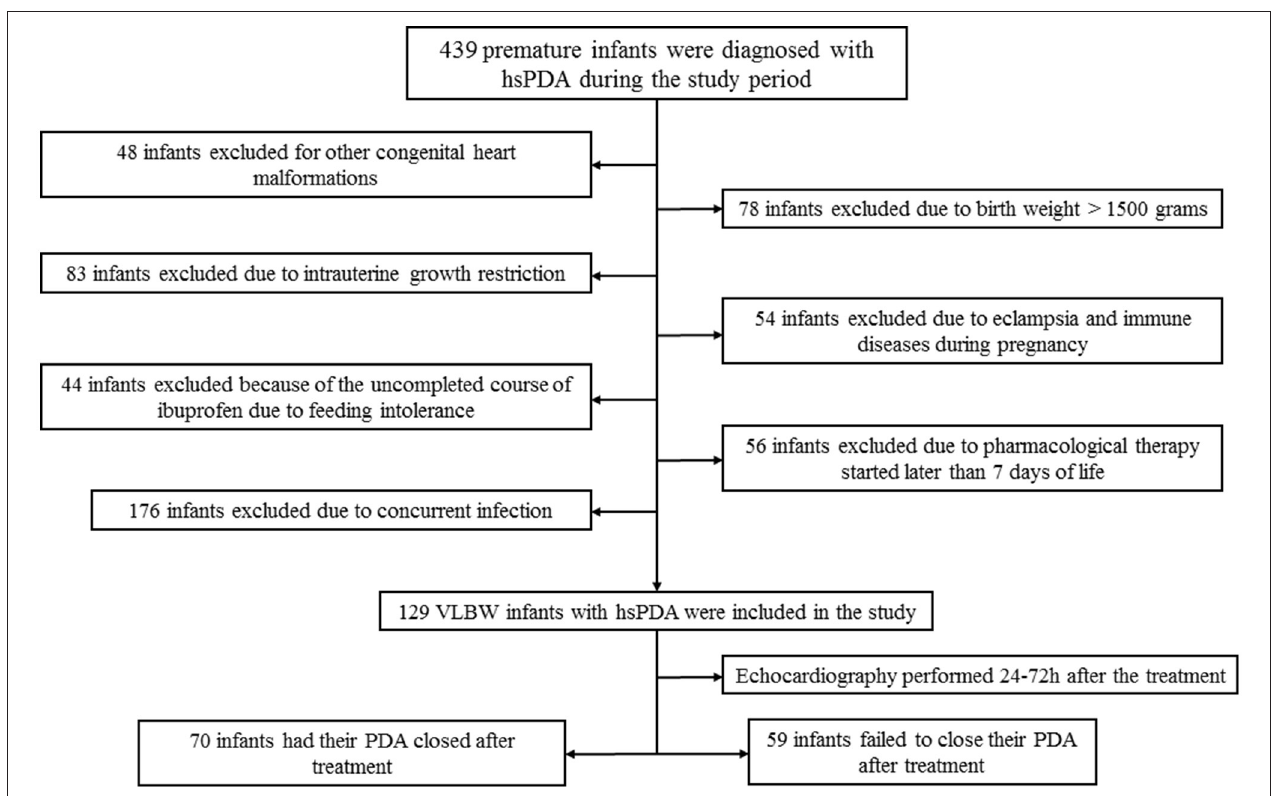
FIGURE 1 | Flow chart of cases selection. hsPDA, hemodynamically significant patent ductus arteriosus; GA, gestational age.